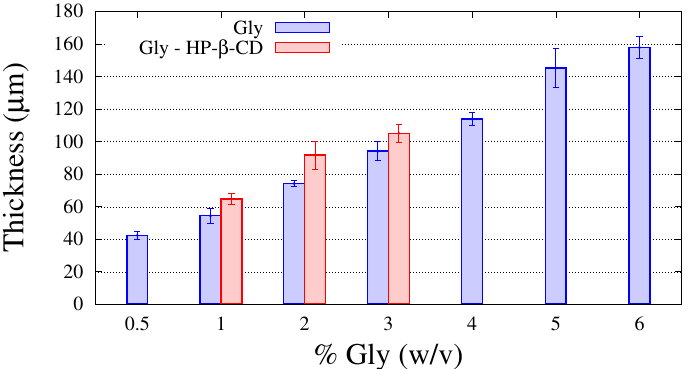
Figure 2. Film thickness for increasing amounts of glycerol, % Gly ( w / v ), with and without hydroxypropyl- β -cyclodextrin (HP- β -CD).